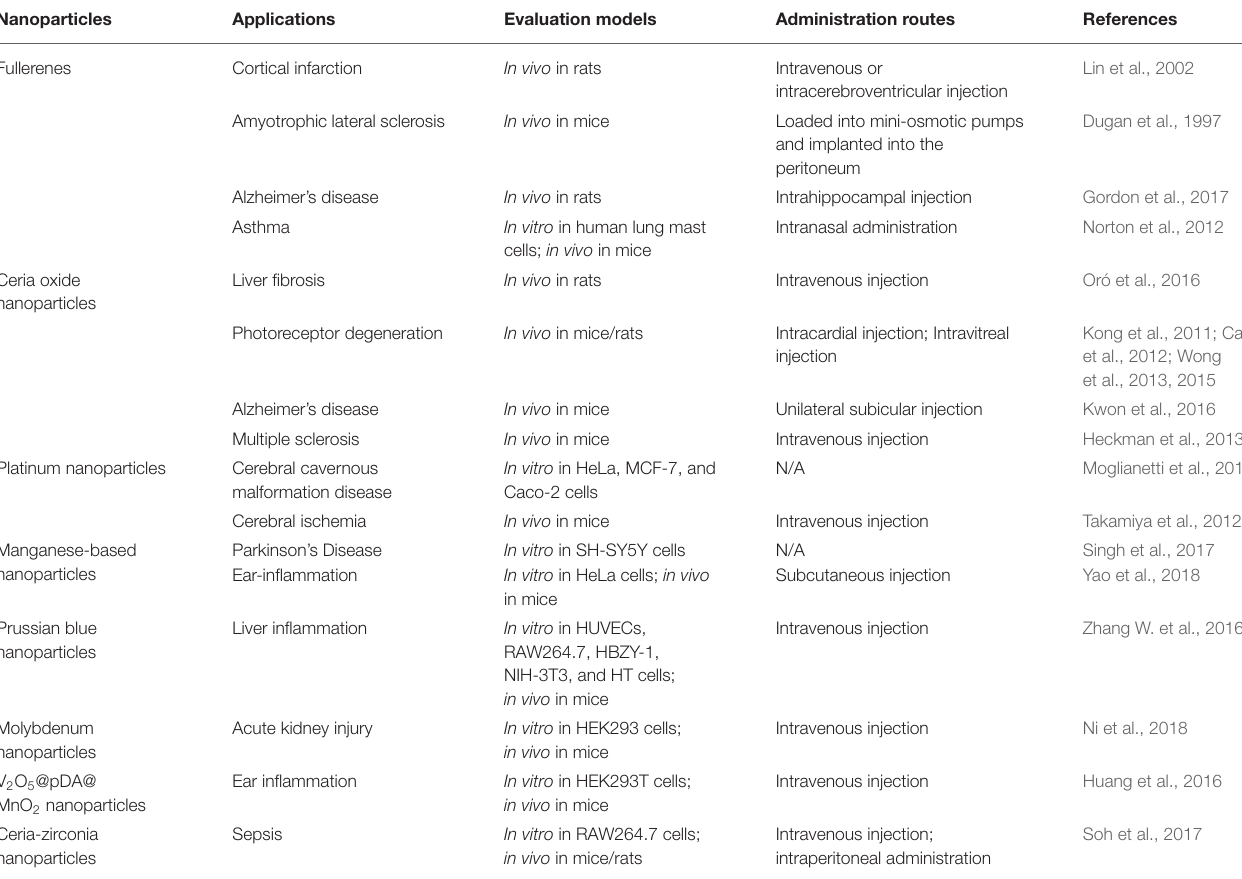
TABLE 1 | Representative ROS-scavenging inorganic